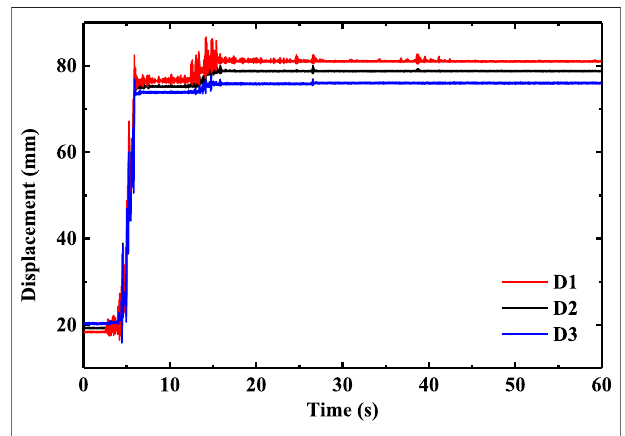
FIGURE 13 | displacement time history curves of slope surface measuring points D1, D2 and D3 under the action of 0.9 g Wenchuan seismic